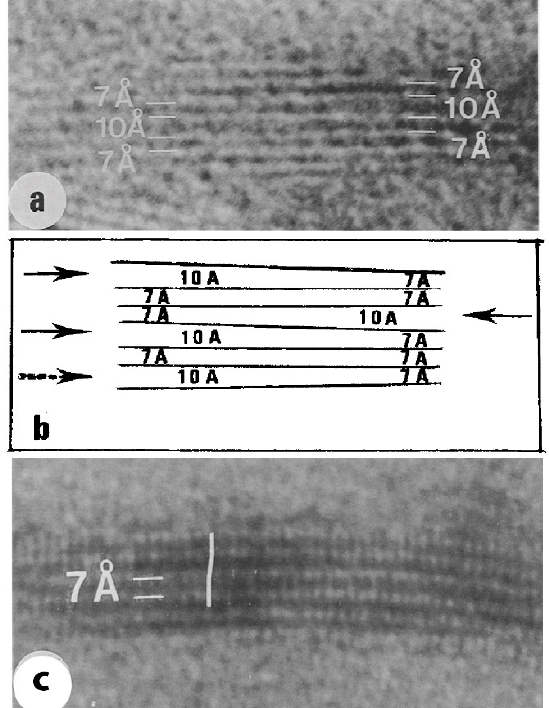
Figure 9. HRTEM micrographs of a richest 7 Å phase off Congo mouth. ( a ) Lattice-fringe image of a rather regular 7/10 Å interstratified structure along c. Note the lateral transformation of one layer of the 7 Å Fe phase to one layer of 10 Å-like mica phase within the (001) plane. ( b ) Schematic representation of ( a , c ). Structure image of one crystallite of the 7-Å Fe phase showing its faulted 1M polytypic sequence, after [29].